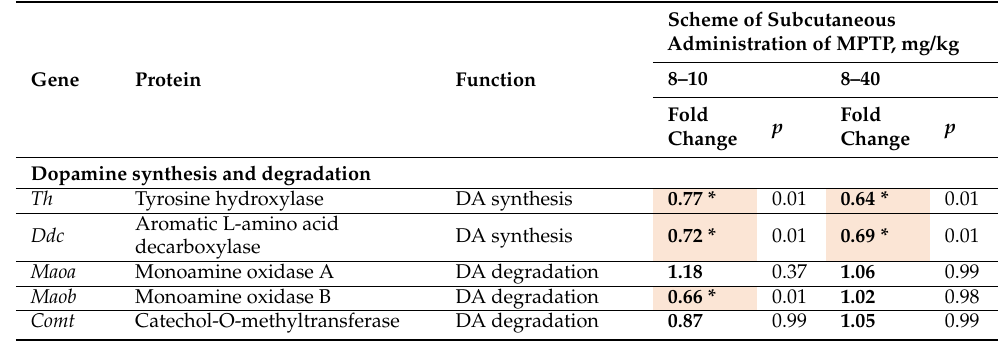
Table 1. Changes in the gene expression of proteins of the dopaminergic phenotype, as well as proteins involved in synaptic neurotransmission and neurodegeneration, 24 h after the last administration of 1-methyl-4-phenyl-1,2,3,6-tetrahydropyridine (MPTP) at increasing doses from 8 to 10 mg/kg and from 8 to 40 mg/kg. The data are presented as ratios of the level of gene expression in the experimental group to the level of gene expression in the control, which was taken as 1.